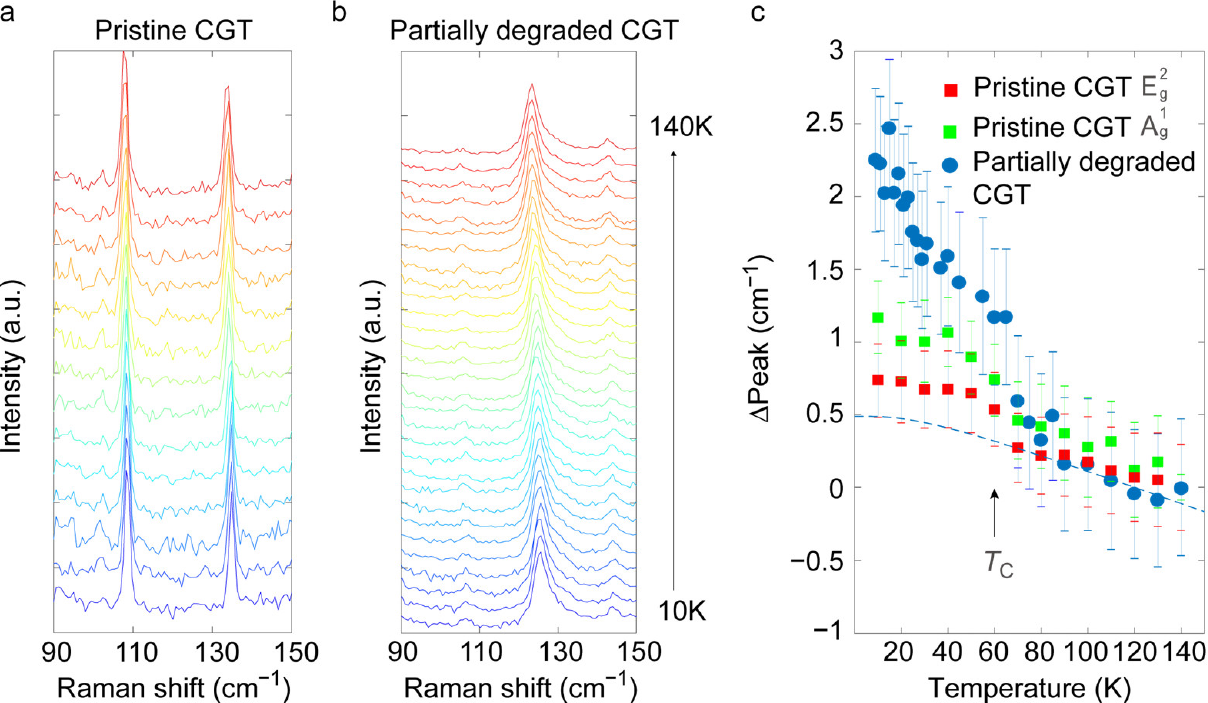
Figure 3. ( a ) Raman spectrum of pristine sample 10 K–140 K. ( b ) Raman spectrum of partially degraded sample 10 K–140 K. ( c ) The peak position of two modes E g 2 and A g 1 for pristine CGT, and P 2 for partially degraded CGT, traced from 10 K to 140 K. Error bars denote the uncertainty of the fittings. Dashed line is a fit according to Equation (1).